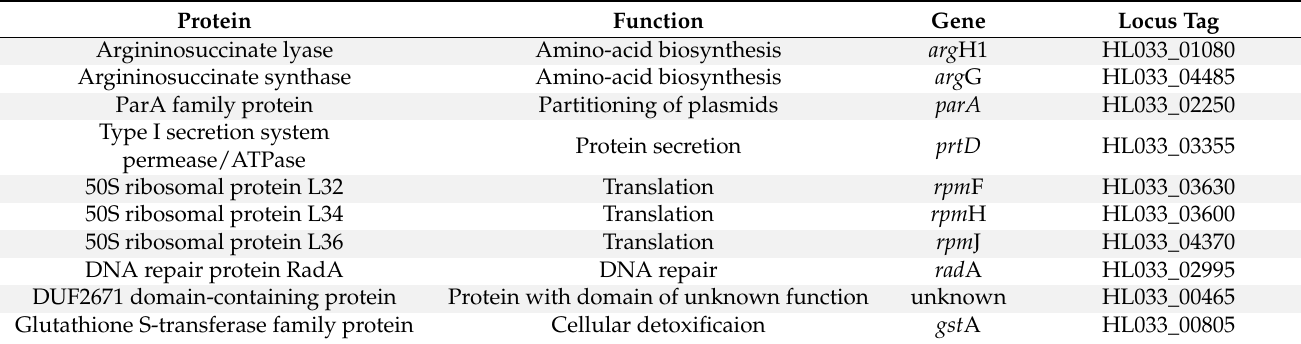
Table 4. Ten proteins predicted to be shared by Ca. Neoehrlichia mikurensis, Ca. Neoehrlichia lotoris, Ehrlichia chaffeensis and Ehrlichia ruminantium